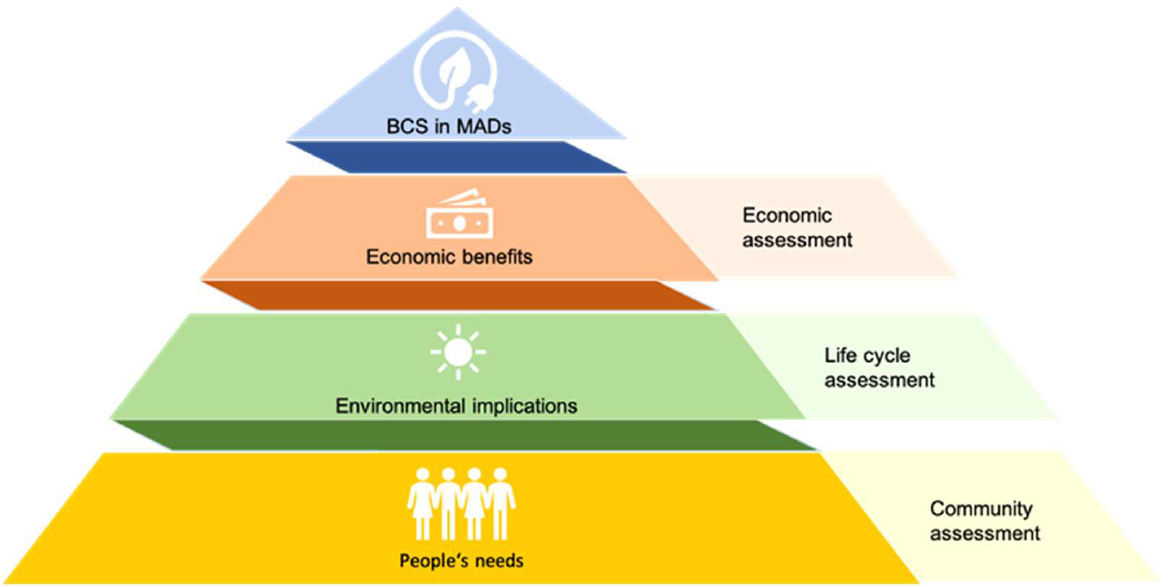
Figure 10. Schematic description of people-centered approach to be considered before implementing new agricultural value chains such as a bioenergy cropping system (BCS) in marginal African dryland (MAD).